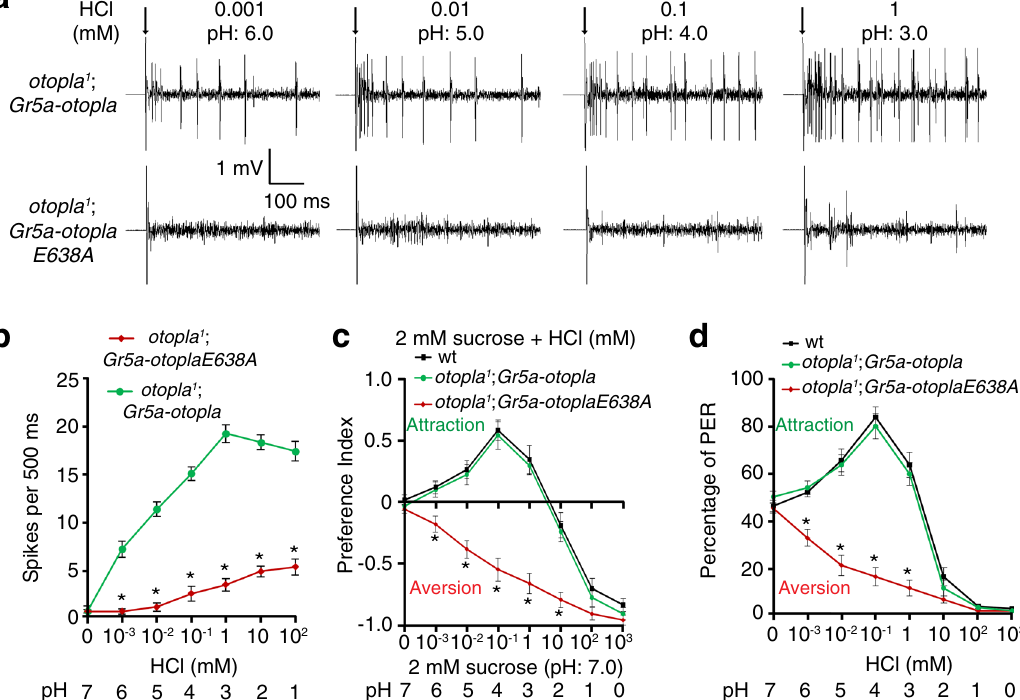
Fig. 7 Responses to acid in fl ies misexpressing OtopLa or OtopLaE638A in sweet GRNs. a , b Action potentials evoked by various concentrations of HCl at L8 sensilla in fl ies misexpressing OtopLa or OtopLaE638A in Gr5a -positive GRNs. Arrows indicate the onset of taste stimuli. Data are presented as mean ± SEM. n = 10 animals, * p < 0.0001 (0.001 – 100 mM), unpaired two-tailed t -tests. c Feeding responses to neutral foods vs. foods with varying concentrations of HCl for wild-type fl ies and fl ies misexpressing OtopLa or OtopLaE638A. Data are presented as mean ± SEM. n = 10 trials, * p = 0.0029 (0.001 mM) and * p < 0.0001 (0.01, 0.1, 1, and 10 mM), one-way ANOVA tests. d PER responses to neutral and acidic foods in wild-type fl ies and fl ies misexpressing OtopLa or OtopLaE638A. Data are presented as mean ± SEM. n = 10 trials, * p < 0.0001 (0.001, 0.01, 0.1, and 1 mM), one-way ANOVA